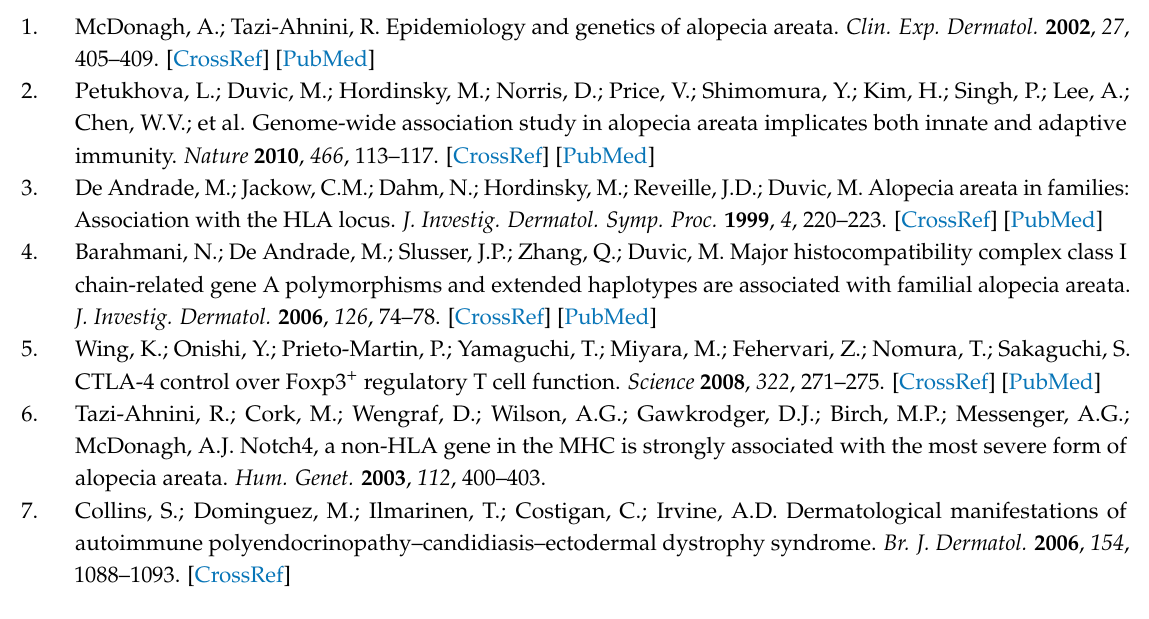
s1, Figure S1: The mean percentage (%) of viable cells in HaCat and Jurkat cell lines after treatment with different concentrations of EGCG (10, 20, 40, 60 and 100 µ M) for 48 h, Figure S2: Morphological features of HaCat cells treated with EGCG, Figure S3: Morphological features of Jurkat cells treated with EGCG, Table S1: Summary of cDNA synthesis protocol, Table S2: Primers used in the q-PCR reactions, Table S3: Thermal profile used in q-PCR reaction, Table S4: Alopecia areata patients’